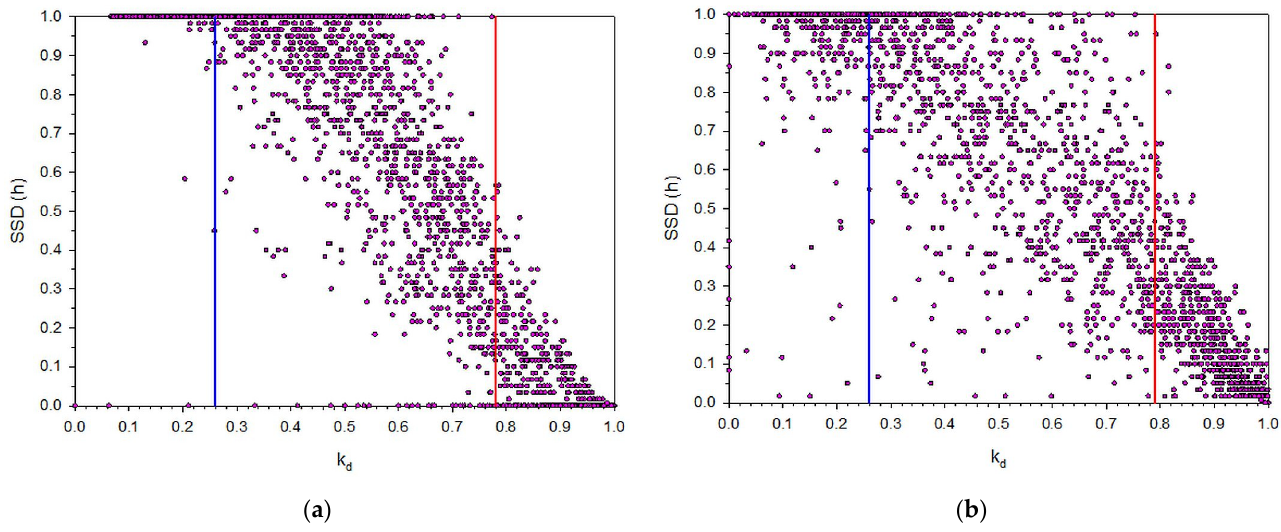
Figure 17. Determination of the k du (red line) and k dl (blue line) values for the ( a ) SON and ( b ) SOV sites.